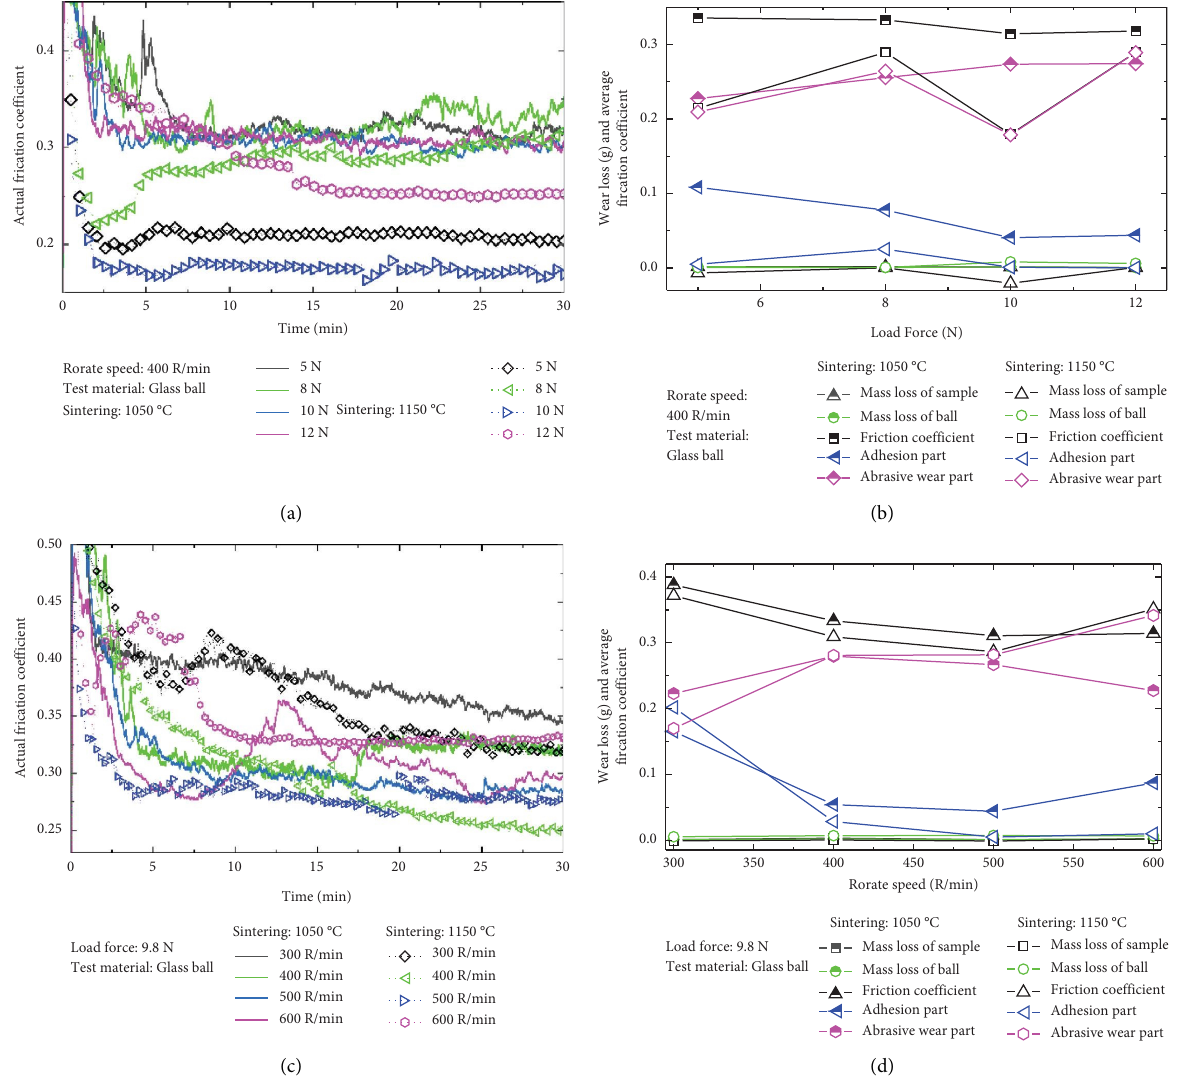
Figure 3: COF (a) and mass loss (b) of the composites with a glass pair under 5–12N; COF (c) and mass loss (d) of the composites at